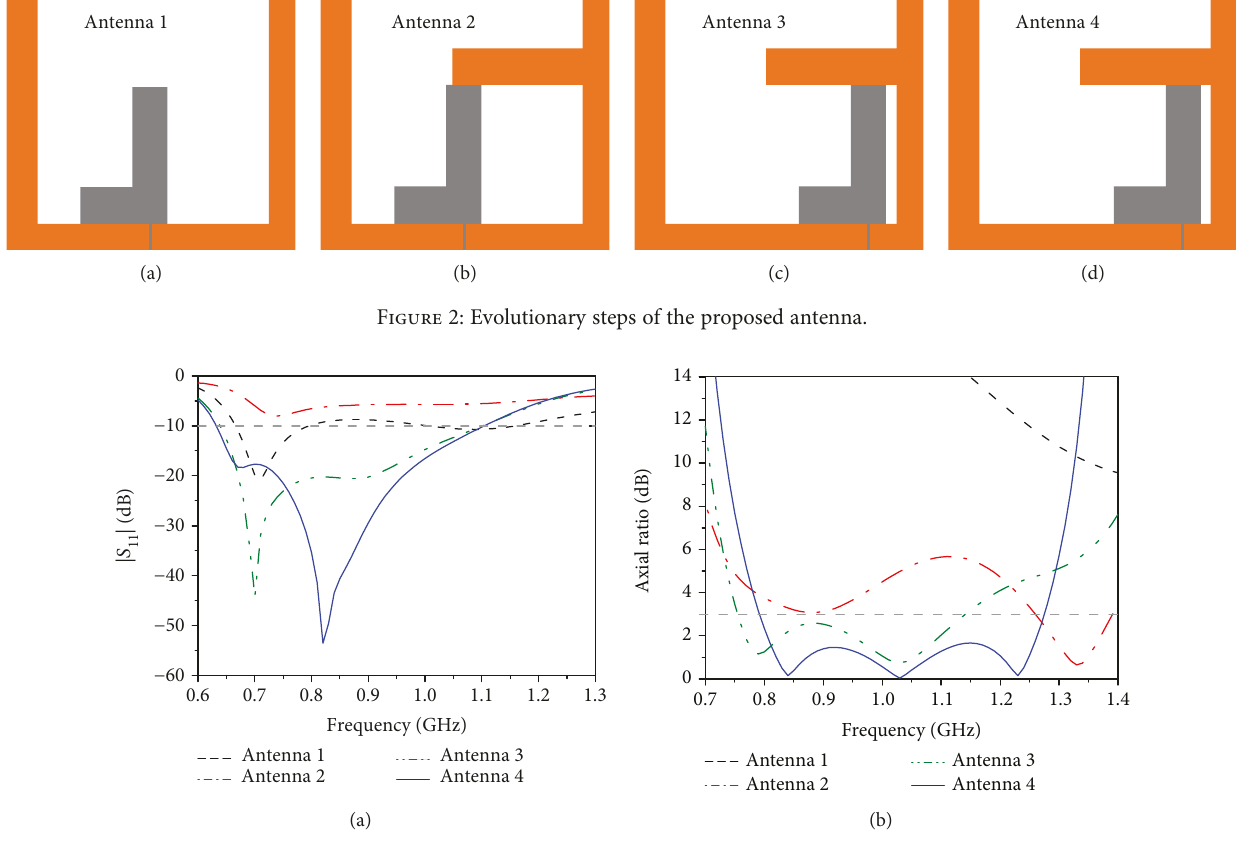
Figure 3: Simulated (a) S 11 bandwidth and (b) AR bandwidth results for Antennas